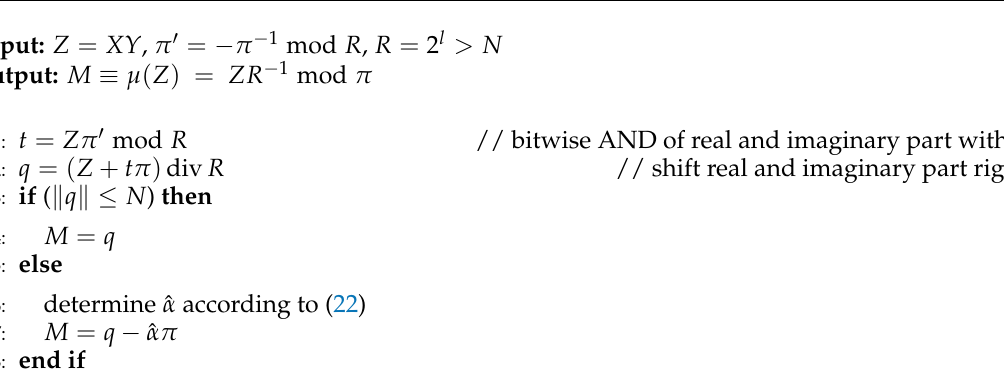
Algorithm 5 Precision reduction for Gaussian integers using the Manhattan weight according to